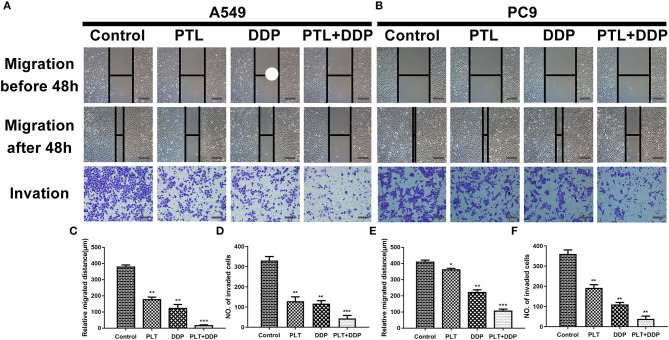
PTL and DDP suppress the migration and invasion ability of A549 and PC9 cells. Representative images of wound healing and transwell assays (A,B) following 48 h of treatment with 30 μM PTL, 0.75 μM DDP alone, and 0.2 μM DDP and 10 μM PTL in combination. Histograms depict the average migrated distance (C,E) and the number of invasive cells (D,F), respectively. All data are shown as the mean ± SD of three independent experiments. *P < 0.05, **P < 0.01 or ***P < 0.001 vs. the control group (magnification, × 100; scale bars, 100 μm).